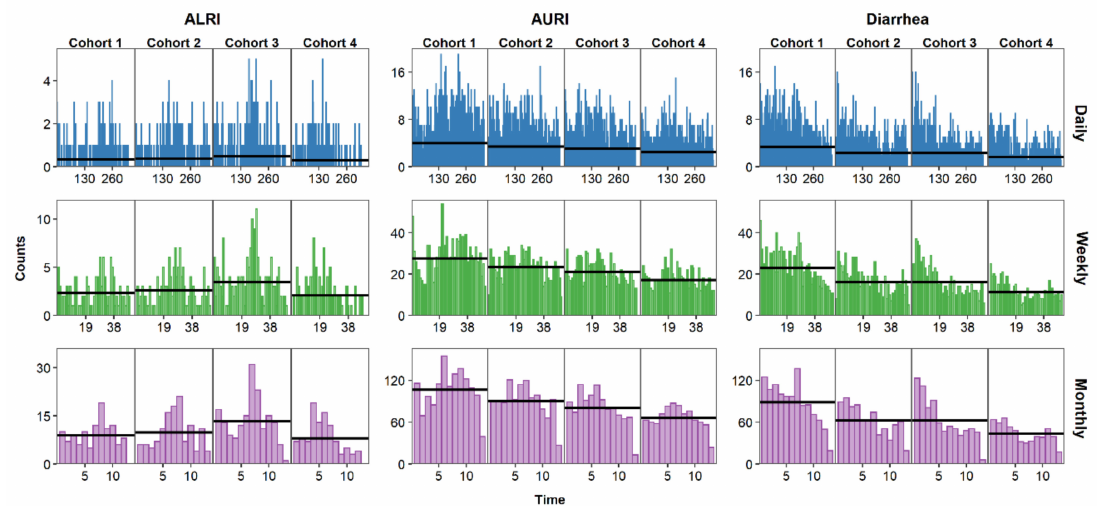
Figure 2. Time series of daily (blue), weekly (green), and monthly (purple) counts of AURI, ALRI, and diarrhea. Black horizontal lines represent the mean for each